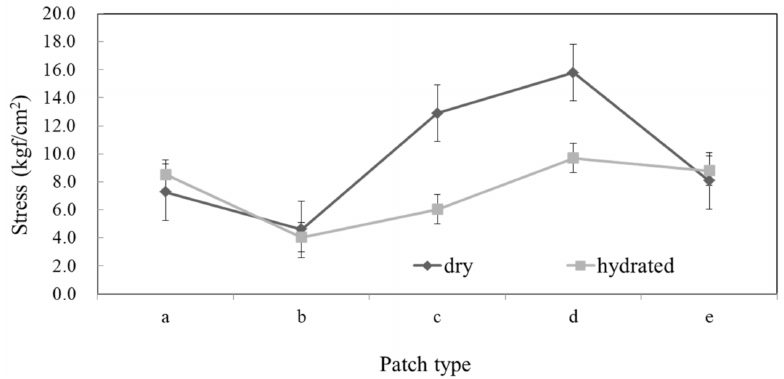
Figure 5. Tensile strength of Centella asiatica extract-loaded hyaluronic acid-dextran (HA-Dex) hybrid hydrogel patches ( n = 3, mean ± SD). Control: HA-Dex hybrid hydrogel patches with no CAE; (a) 9.8:0.2, (b) 9.6:0.4, (c) 9.4:0.6, (d) 9.2:0.8, and (e) 9:1 wt% HA-Dex: